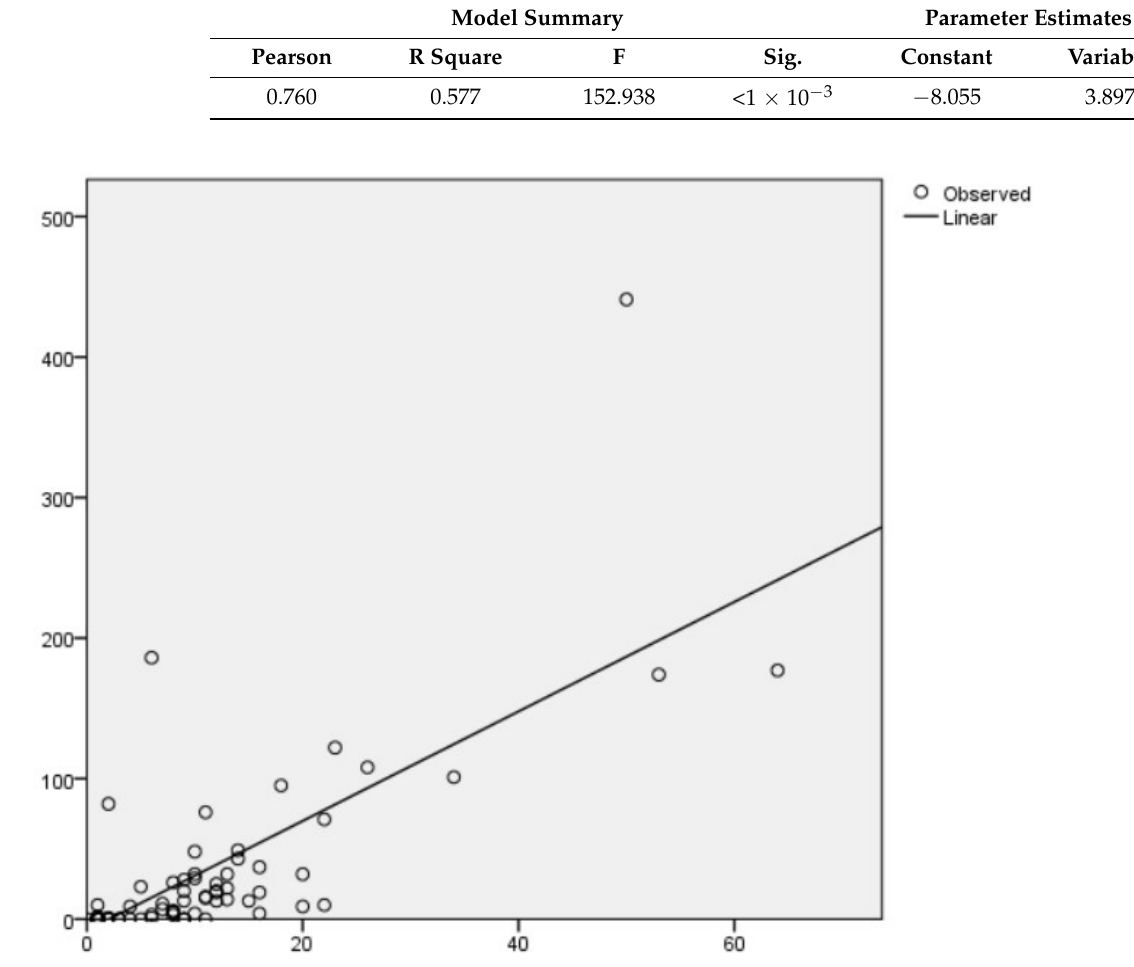
Figure 8. Linear regression model between the number of partners and number of publications.